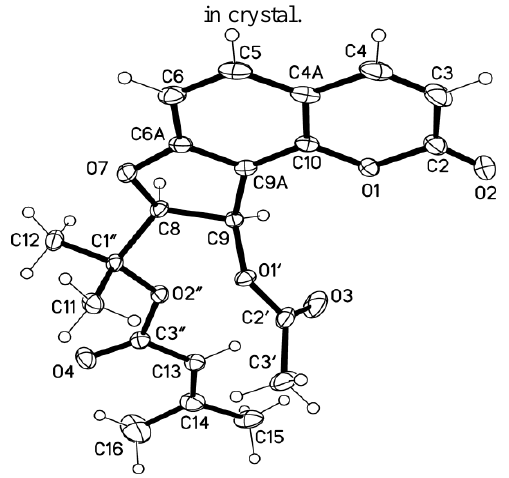
Figure 1. Spatial structure of peucenidin ( 8 ) molecule in